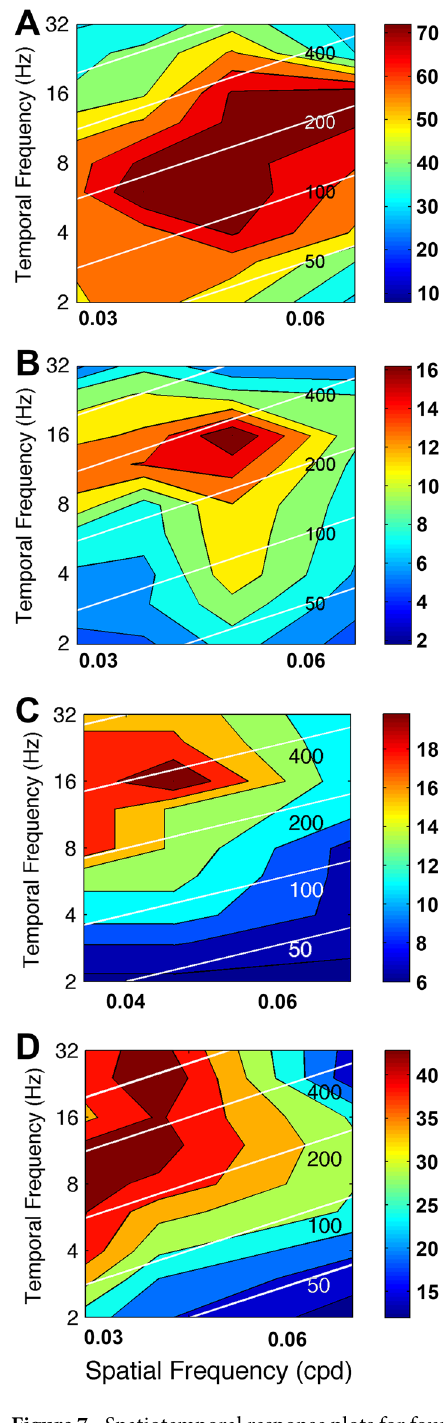
Figure 7. Spatiotemporal response plots for four DNIII neurons. ( A ) The spatiotemporal tuning of DNIII 2 (as presented in Fig. 6C). This is repeated to allow direct comparison with the cells below. ( B , C ) Spatiotemporal response profiles for three neurons that were anatomically of the DNIII-type but without detailed dendrites, making specific identification difficult. The plots are arranged in such a way that the peak spatial frequency sensitivity declines from ( A – D) . Therefore, the cell in ( D ) is tuned to lower spatial frequencies than the other three recordings. White diagonal lines indicate constant speeds, as indicated by the values printed on the plots (50, 100, 200, 400 and 800°/s). Color bars to the right indicate the mean number of spikes/s in the